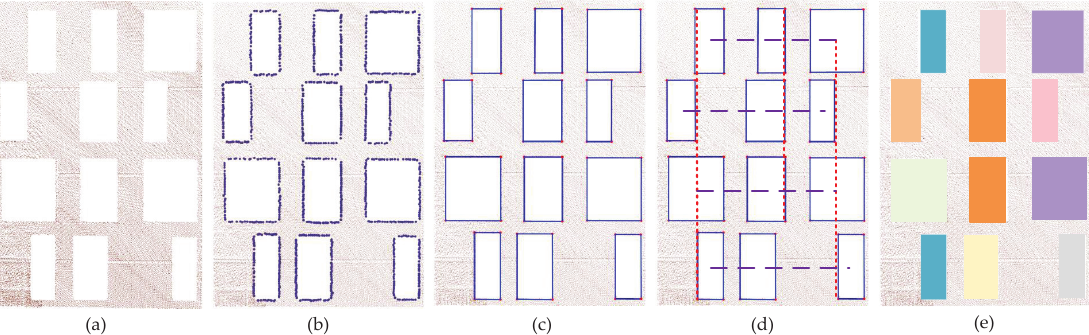
Figure 1. Overview of the proposed pipeline through the flexible inference machine. ( a ) Input point cloud; ( b ) Detected wall openings; ( c ) Initial reconstruction of wall openings; ( d ) Inference of opening association (red dotted lines and purple dash lines represent partly vertical and horizontal alignment rules respectively); ( e ) Adjusted openings with associations represented in the same